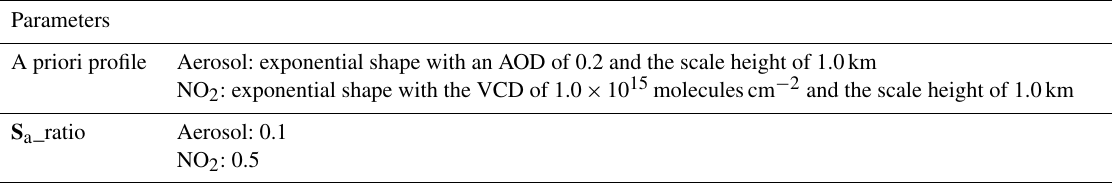
Figure 4. Comparison of the PriAM inversion results with different alternative a priori profiles and the results for the universal a priori (exponential shape with AOD 0.2). The first line in every panel denotes the results for 360nm, and the second line denotes the results for 477nm. Colors indicate the shapes and AODs shown at the top. “Corresponding a priori profile” means that the same profile type as the simulated profiles is also used as the a priori profile. Table 4. Parameter settings used in the general PriAM retrieval for aerosol and NO 2